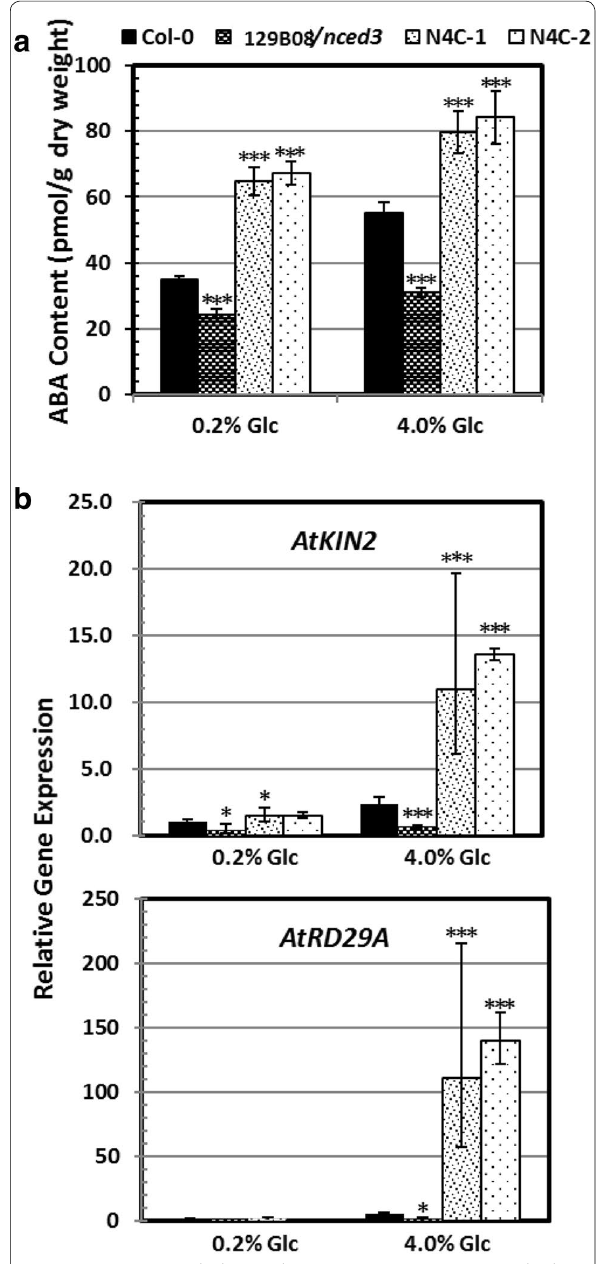
Fig. 5 Transgenic Arabidopsis plants overexpressing OsNCED4 had increased ABA content and expression of ABA‑mediated stress‑ responsive genes. a ABA content in seedlings of Col‑0, 129B08/ nced3 mutant, and two N4C transgenic lines grown on agar medium sup‑ plemented with 0.2 or 4% Glc for 10 days. b Relative transcript levels of AtKIN2 (upper panel) and AtRD29A (lower panel) in seedlings of Col‑0, 129B08/ nced3 mutant, and two N4C transgenic lines grown on agar medium supplemented with 0.2 or 4% Glc for 10 days. The val‑ ues are the mean SD of three independent experiments. * P < 0.05; ± *** P < 0.001, Student’s t test